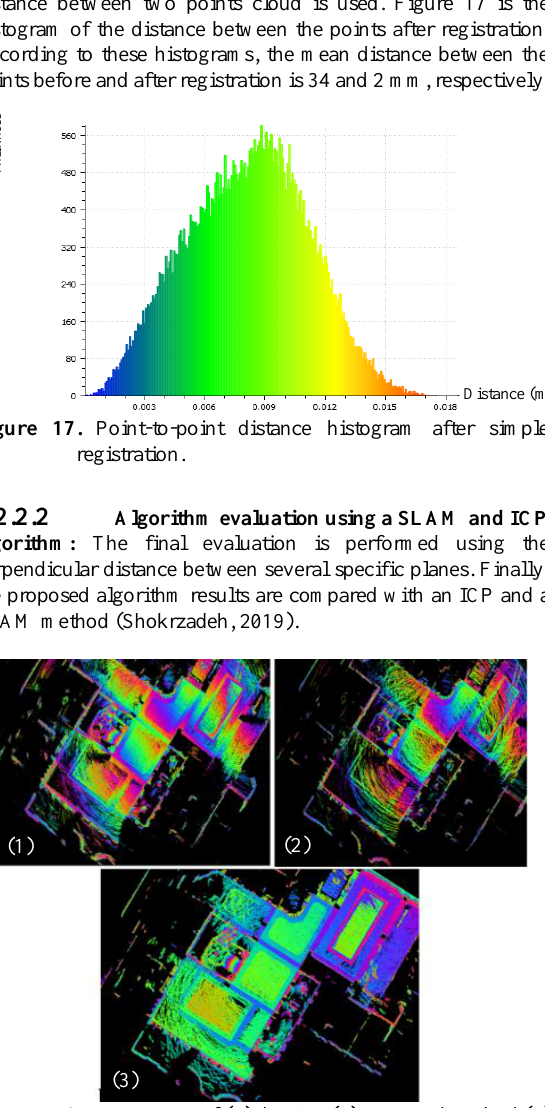
Figure 118. Output map of (1) the ICP (2) proposed method (3) Shokrzadeh method.